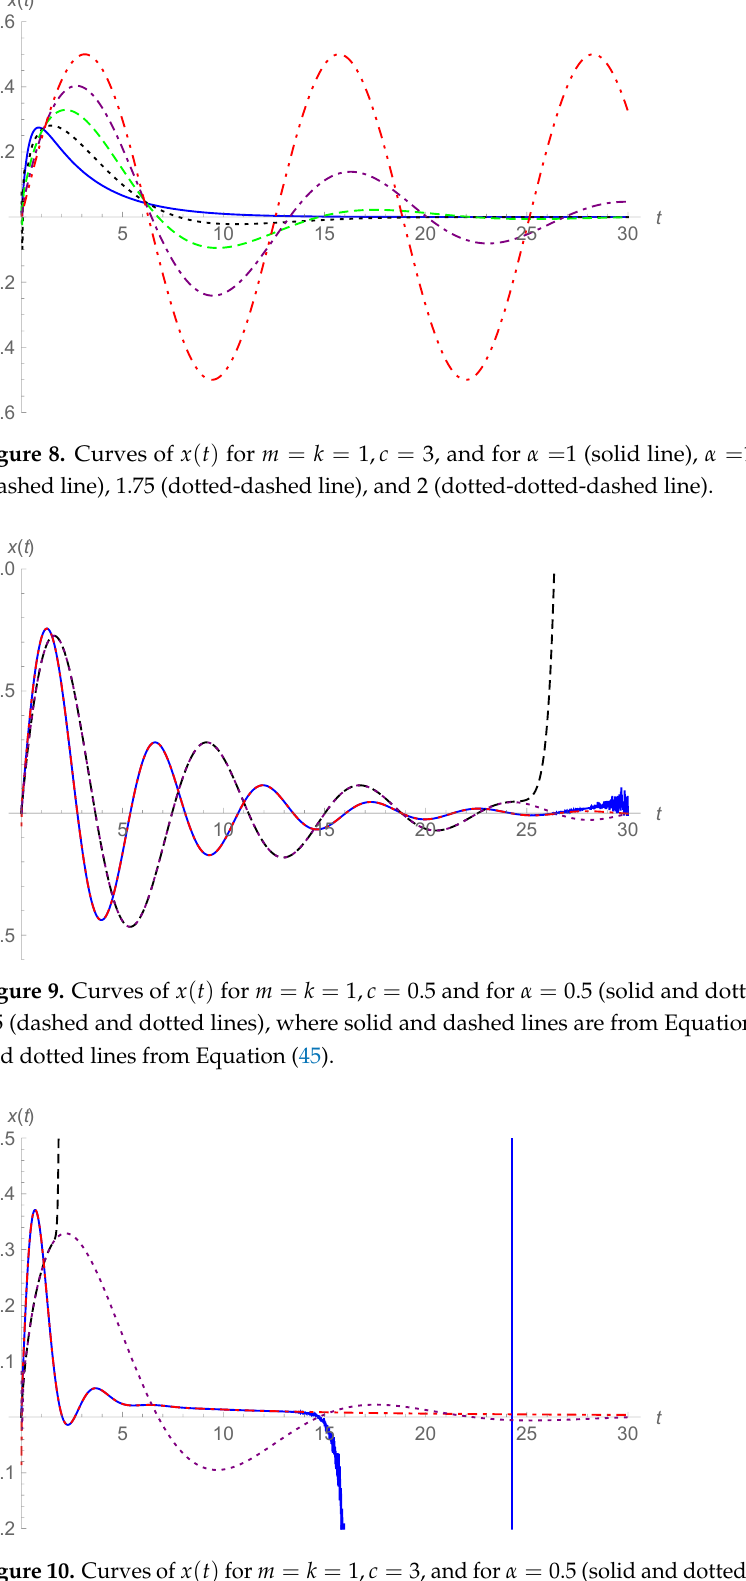
Figure 10. Curves of x ( t ) for m = k = 1, c = 3, and for α = 0.5 (solid and dotted-dashed lines) and 1.5 (dashed and dotted lines), where solid and dashed lines are from Equation (17), and dotted-dashed and dotted lines from Equation